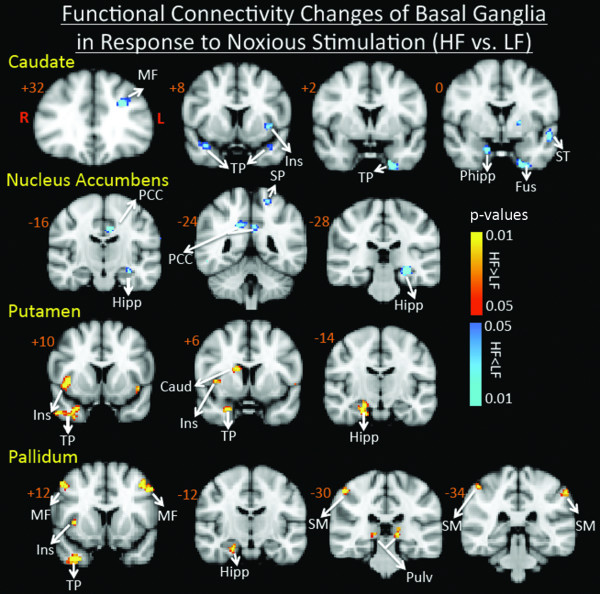
Functional Connectivity Contrast Maps of the Basal Ganglia Nuclei. Functional connectivity contrast maps of the basal ganglia nuclei during intermittent heat stimuli (pain threshold +1°C on hand) in high frequency migraine patients vs. low frequency migraine patients. PCC: Posterior Cingulate Cortex, SM: SupraMarginal, SF: Superior Frontal, ST: Superior Temporal, SP: Superior Parietal, Ins: Insula, Hipp: Hippocampus, PHipp: Parahippocampus, Fus: Fusiform, Thal: Thalamus, Pulv: Pulvinar, TP: Temporal Pole, MF: Middle Frontal.